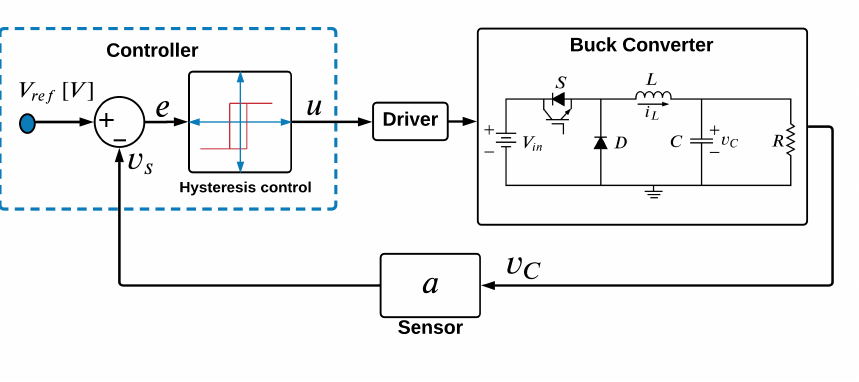
Figure 4. Schematics of the closed-loop control system for the Buck converter using a constant hysteresis